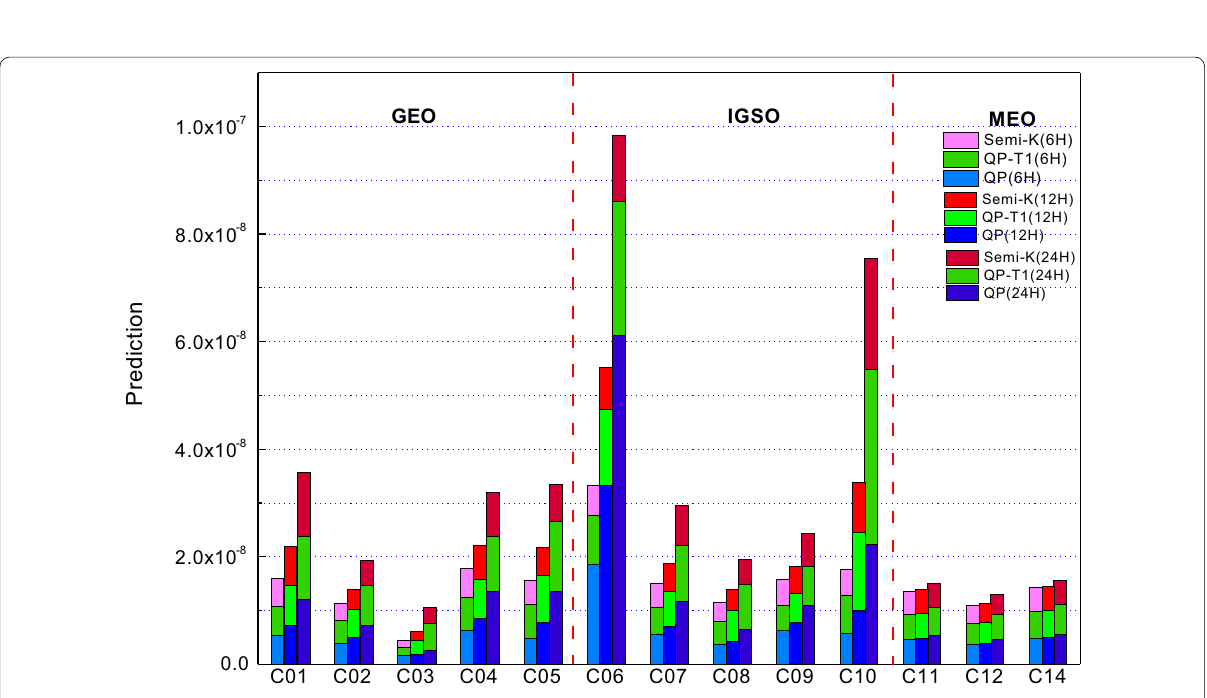
Fig. 7 Statistical fitting accuracy of Semi-K model